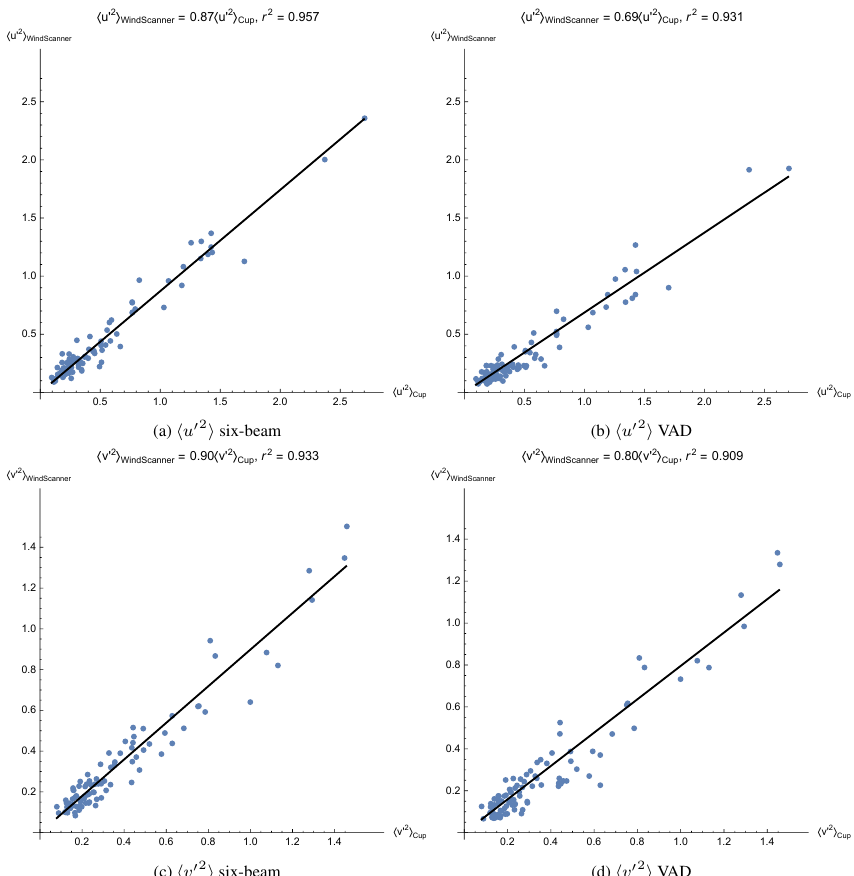
Figure 6. Comparison of the turbulence statistics under neutral conditions between the WindScanner and the cup anemometer using two Fig. 6: Comparison of the the turbulence statistics under neutral conditions between the WindScan- ner and the cup anemometer using two methods scatter using the six-beam method for